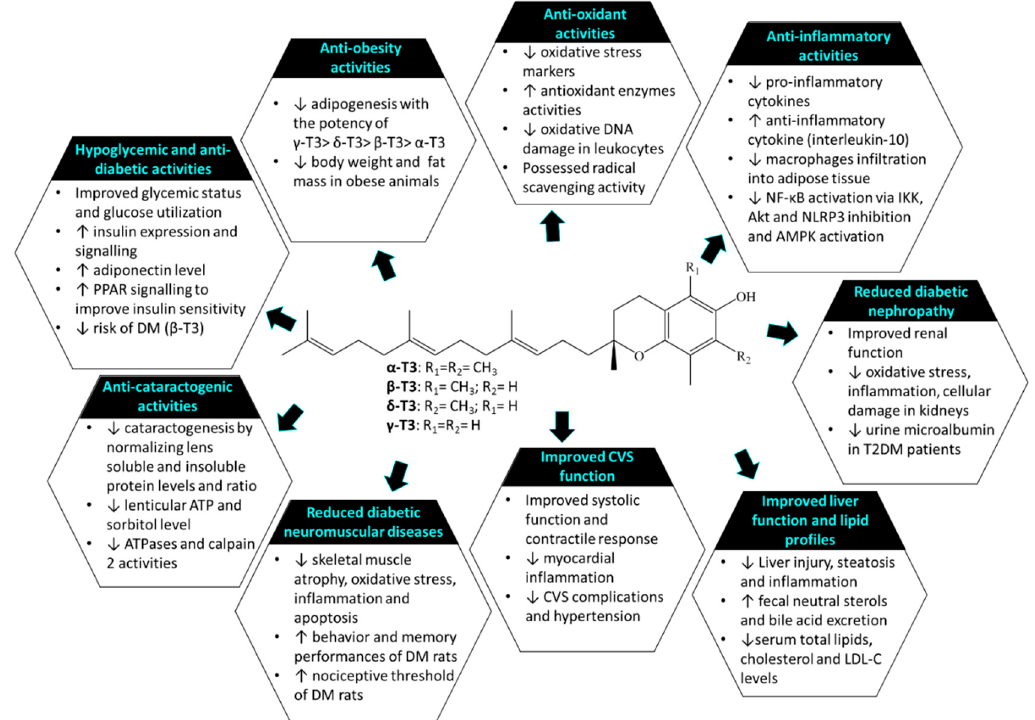
Figure 10. Beneficial effects of T3 on obesity and diabetes.